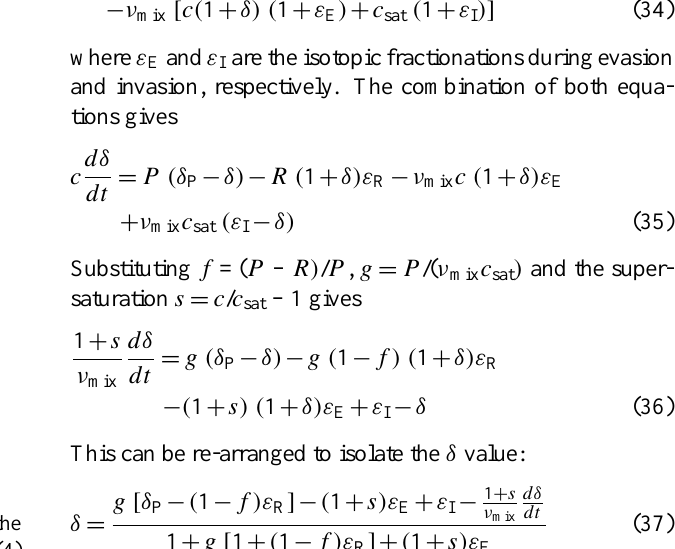
Fig. 1. Effect of the net to gross production ratio f on the steady-state 17 O excess defined by Eq. (7), i.e. 17 1 # , and Eq. (4) i.e. 17 1 , with λ = κ = γ R = 17 ε R / 18 ε R = 0.5179, 18 ε R =− 20‰, 18 δ 17 δ P =− 23.323‰ and P =− 11.902‰. The steady-state δ val- ues used to calculate the steady-state 17 O excess have been calcu- lated according to Eq.